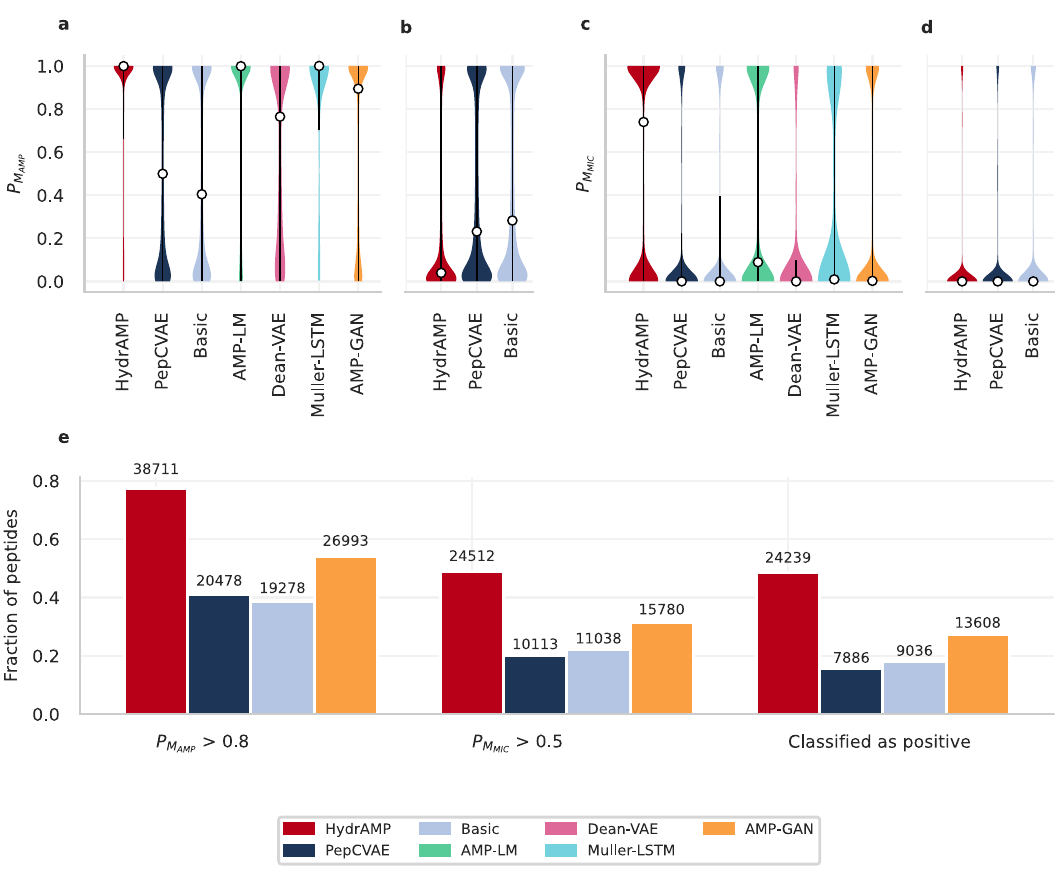
Fig. 4 | Unconstrained generative performance of HydrAMP (red), in compar- ison to PepCVAE (dark blue), Basic (light blue), AMP-LM (green), Dean-VAE (pink),Muller-LSTM(aquamarine),andAMP-GAN(orange)(methodsindicated onthex-axis).a,b Thedistributionofprobabilitiesofbeingantimicrobial( P M for the task of generating positive peptides ( a ) and for the task of generating negative peptides ( b ). c, d The distribution of probabilities of being highly active ) for the task ofgenerating positive peptides ( c ) and for the (having low MIC, P M MIC taskofgeneratingnegativepeptides( d ).Inpanels a,b,c,d ,thewhitedotsmarkthe median of each distribution. The black verticallines denote theinterquartile range